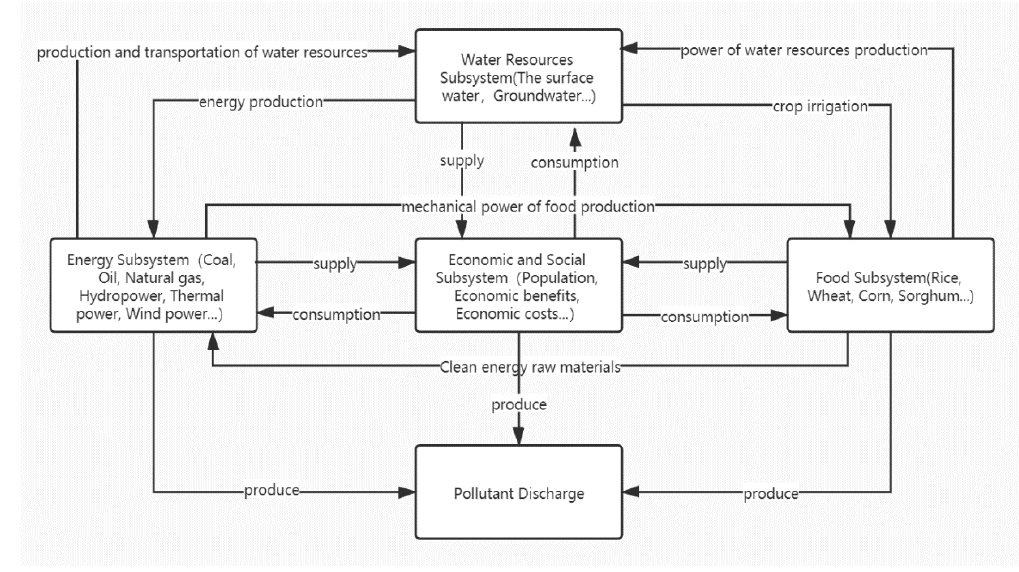
Figure 1. Diagram of Subsystem Relationships in WEF.